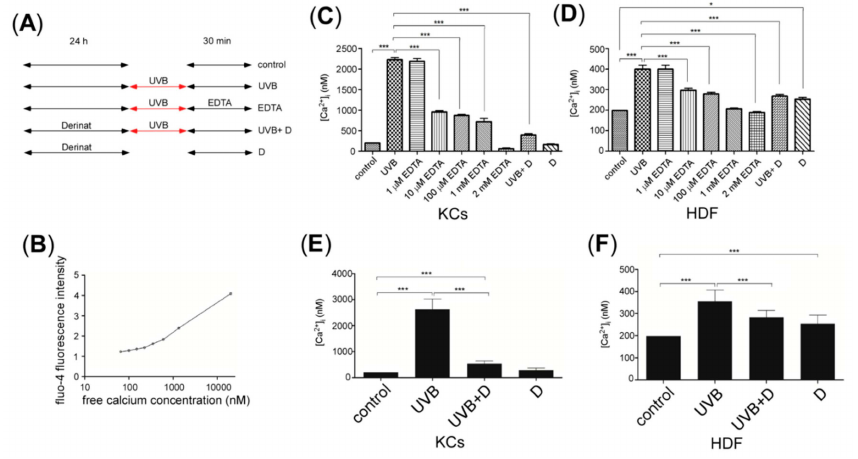
Figure 2. The effect of Derinat on the intracellular Ca 2+ concentration of UVB-exposed skin cells. ( A ) Experimental design for the treatment of each group: control, UVB, EDTA, UVB+D and Derinat only; ( B ) Ca 2+ calibration curve; ( C , D ), Mean value of intracellular Ca 2+ for control, UVB-exposed, UVB-exposed with different concentrations of EDTA, UVB-exposure with Derinat and Derinat in KCs and HDF cultured in BSS for 30 min ( * , p < 0.05; *** , p < 0.001); ( E ) KCs and ( F ) HDF were pretreated with or without the Derinat for 24 h and exposed to UVB. The intracellular Ca 2+ concentration was then measured after 24 h of incubation in normal medium ( *** , p <